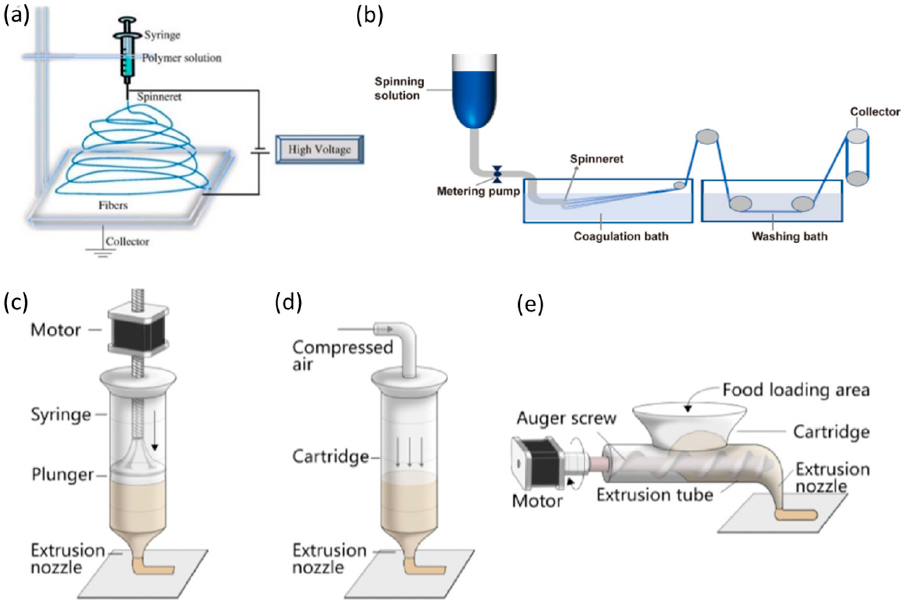
Figure 3. ( a ) Standard vertical setups of electrospinning process setup reprinted from [53] with permission. ( b ) Schematic description of a wet-spinning process for plant proteins, reprinted from [55]. ( c ) Syringe-based type extrusion, ( d ) air-pressure-driven extrusion, ( e ) screw-based type extrusion. ( c – e ) reprinted from Sun and others with permission [56].